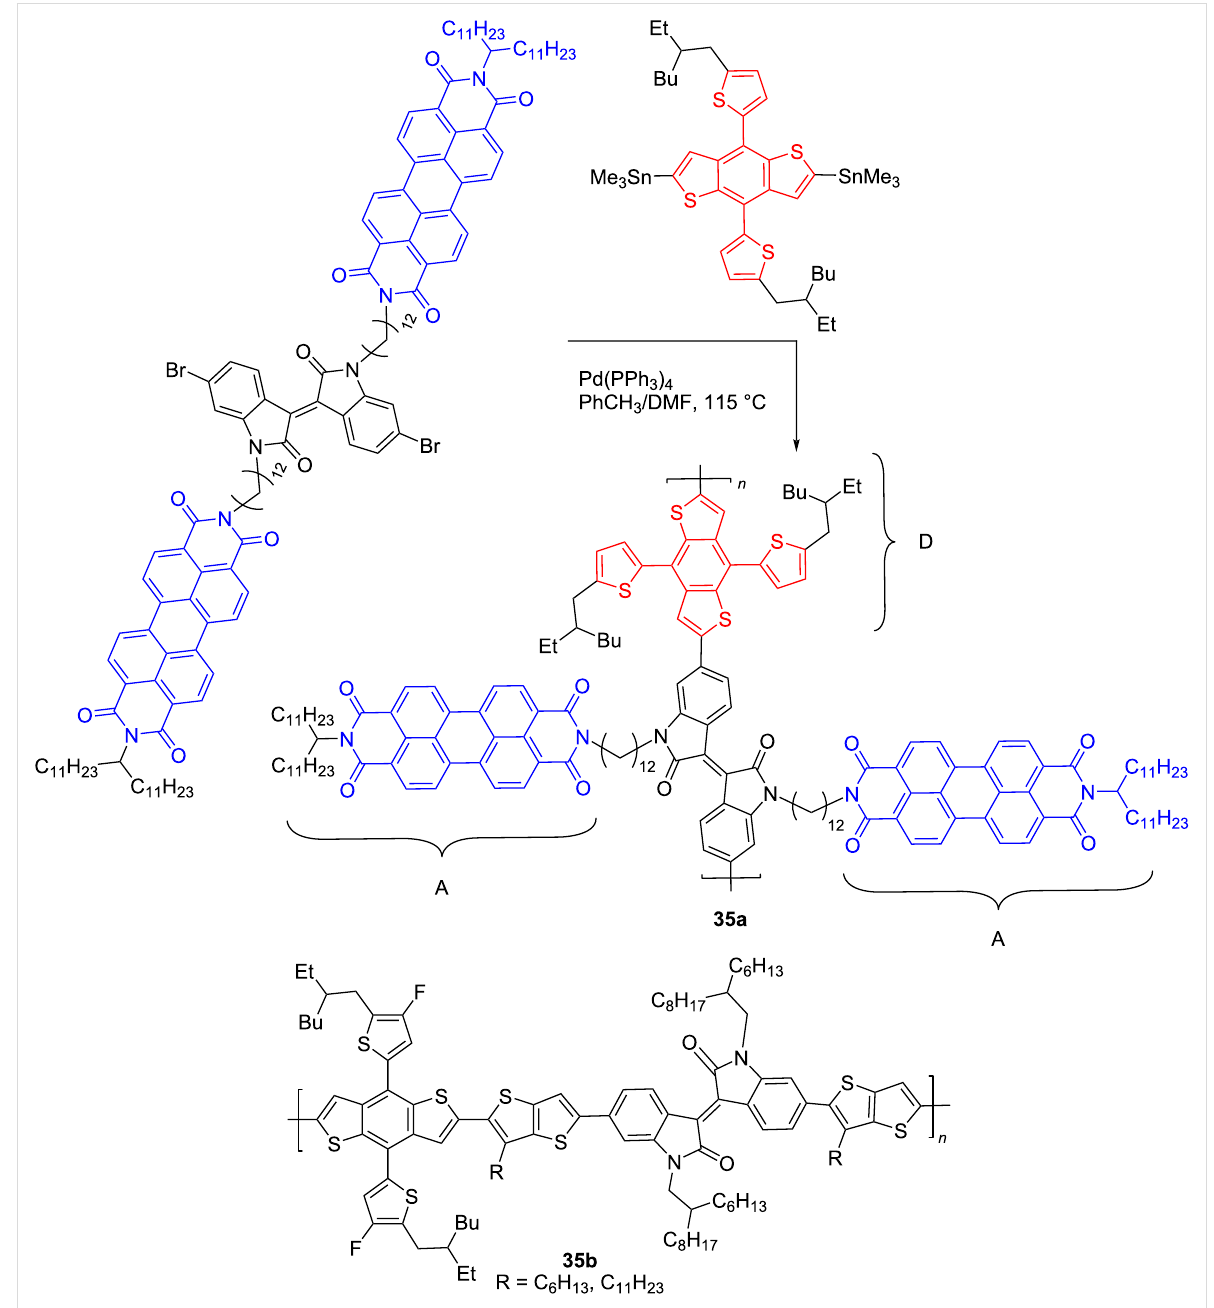
Scheme 19: One-component nonfullerene OSCs on the base of isoindigo.